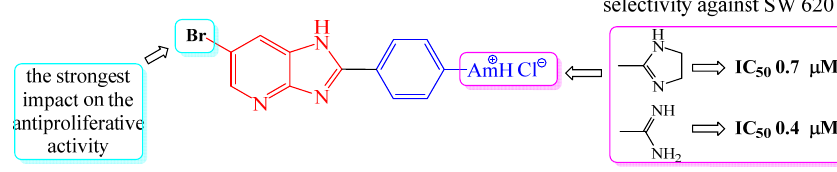
Figure 3. Structure–activity relationship regarding in vitro antiproliferative activity.